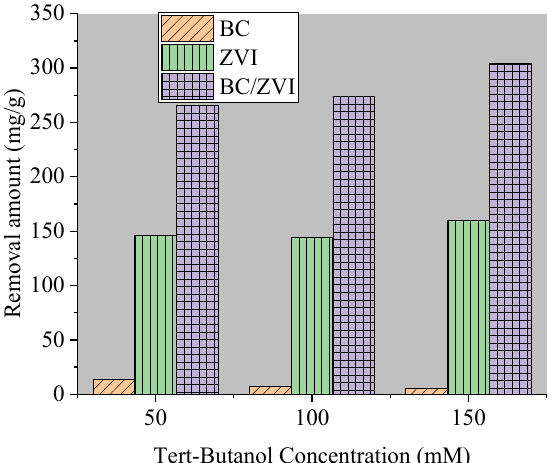
Figure 8. Effect of tert-butanol on TC removal efficiency of three materials.